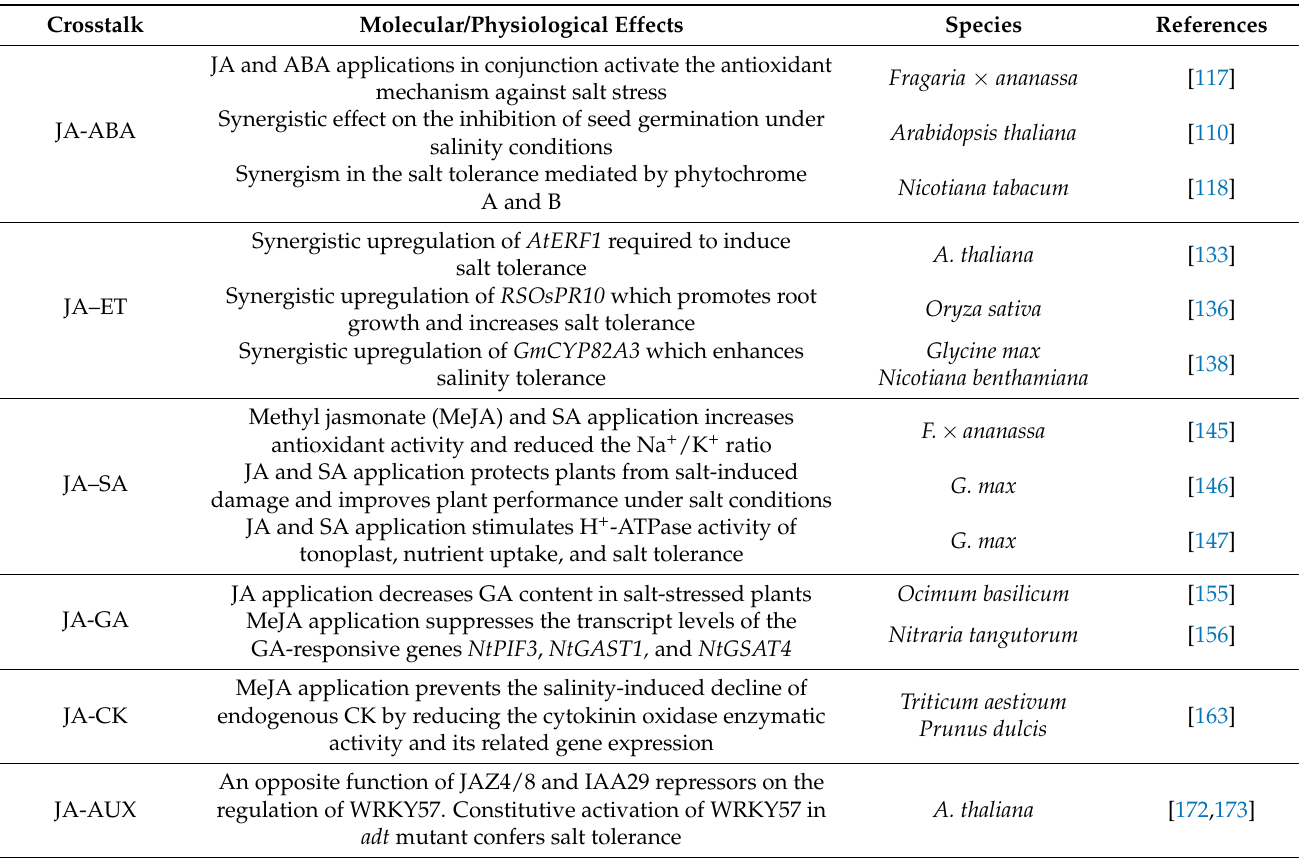
Table 2. Molecular and physiological effects of the jasmonate (JA) crosstalk with abscisic acid (ABA), ethylene (ET), salicylic acid (SA), gibberellins (GA), cytokinin (CK), and auxin (AUX) in different plants under salt stress conditions. For more details, see the